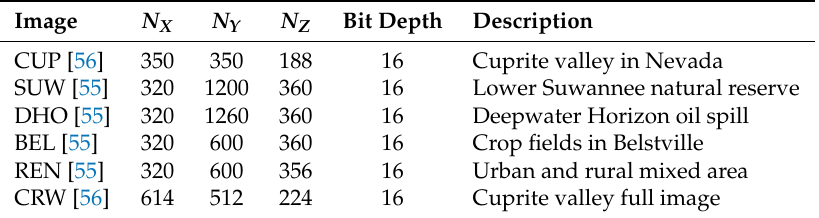
Table 3. Images used for